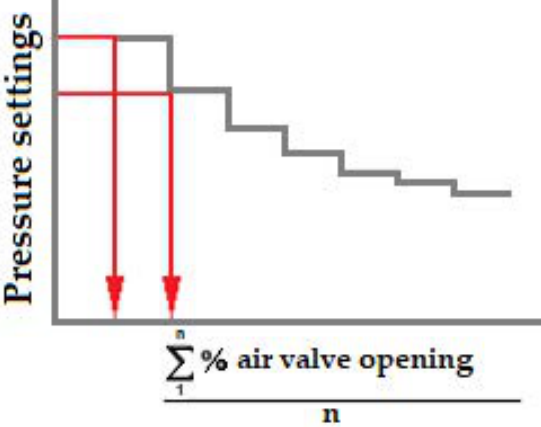
Figure 7. Graph to determine the degrees of opening of the air